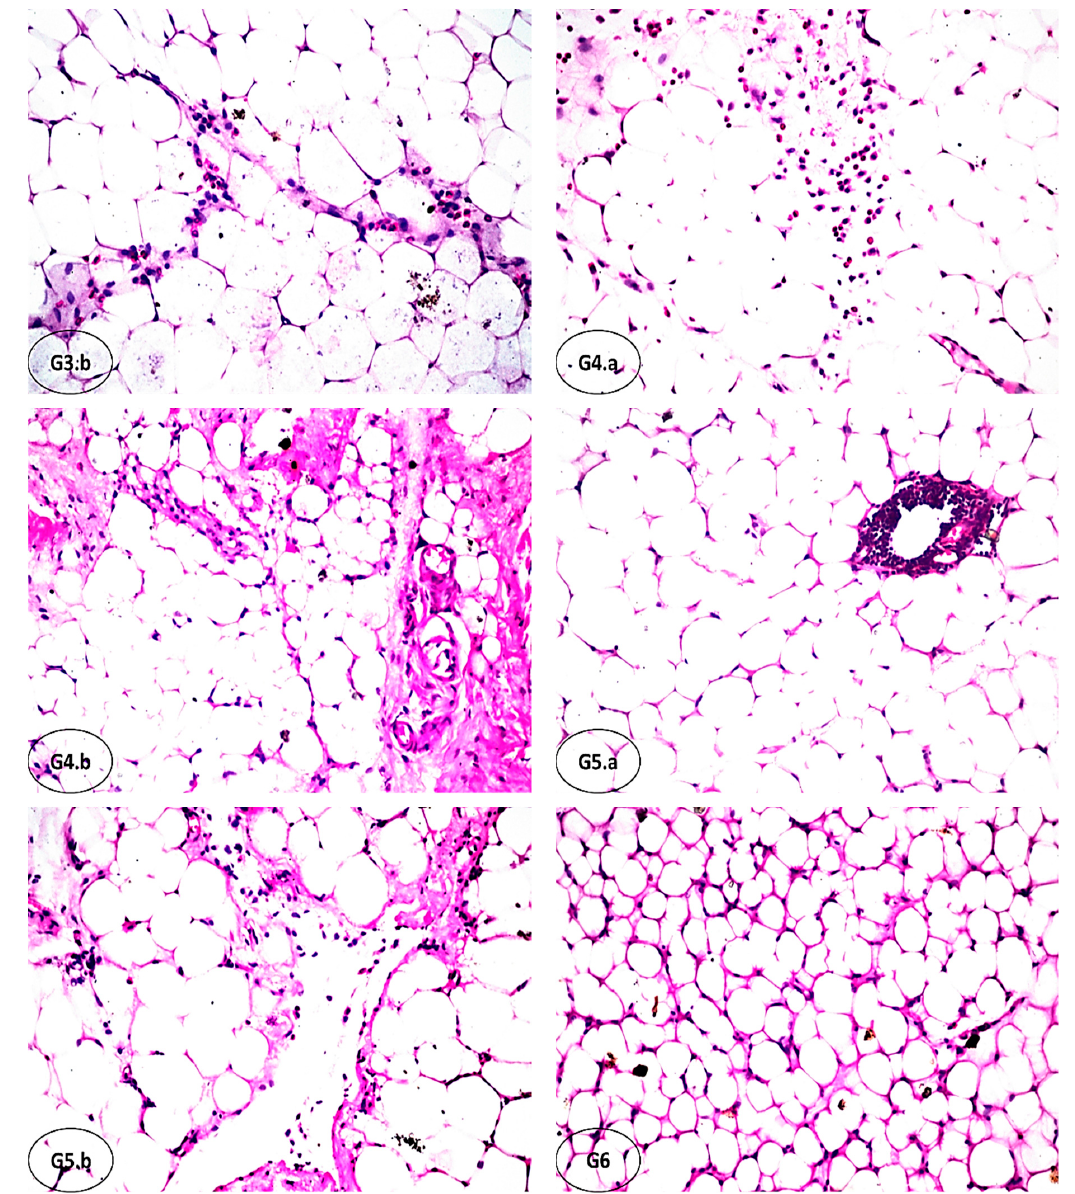
Figure 3. Histopathological findings of rats’ PAT of the experimental groups (hematoxylin–eosin, HE; x 16 ). ( G1 ): no histopathological alteration, and the normal histological structure of adipoblasts as hexagonal shapes with a thin rim of cytoplasm, flattened nuclei, and very fine connective tissue stroma dividing the parenchyma into lobules was confirmed ( x 16). ( G2.a ) and ( b ): severe dilatation and congestion were observed in the stromal blood vessels, associated with diffuse inflammatory cells infiltration with focal hemorrhages and sclerosis in the vascular wall of the blood vessels; focal massive inflammatory cell aggregations, mainly eosinophils, were detected between the parenchyma cells. ( G3.a ) and ( b ): inflammatory cell infiltration in the thick stroma between the parenchyma cells with diffuse inflammatory cell infiltration, mainly eosinophils, was detected between the adiopoblasts. ( G4.a ) and ( b ): focal inflammatory cell infiltration, mainly eosinophils, was detected in the parenchyma, associated with hyalinization of the connective tissue stroma. ( G5.a ) and ( b ): focal inflammatory cell aggregation, particularly lymphocytes, was detected in the parenchyma, associated with congestion in stromal blood vessels; focal inflammatory cells were observed in the parenchyma, associated with hyalinization of the connective tissue stroma. ( G6 ): no histopathological alteration in most of the tissue, except for a few focal areas of inflammatory cell infiltration of the